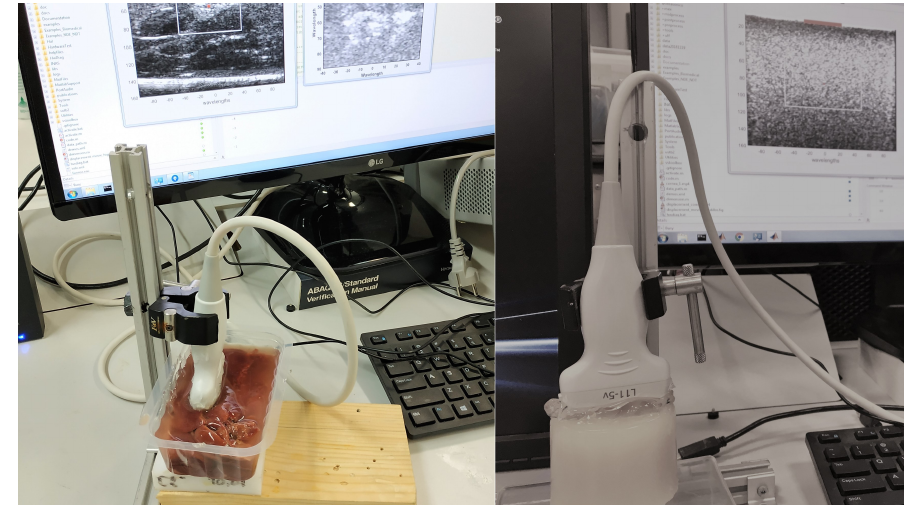
Figure 5. Set-up for measurements using SWEI. The picture was taken during the measurements at the Ultrasonics Lab at the University of Granada. In the left image, the ex vivo liver sample is measured while one of the hydrogel phantoms is shown in the right